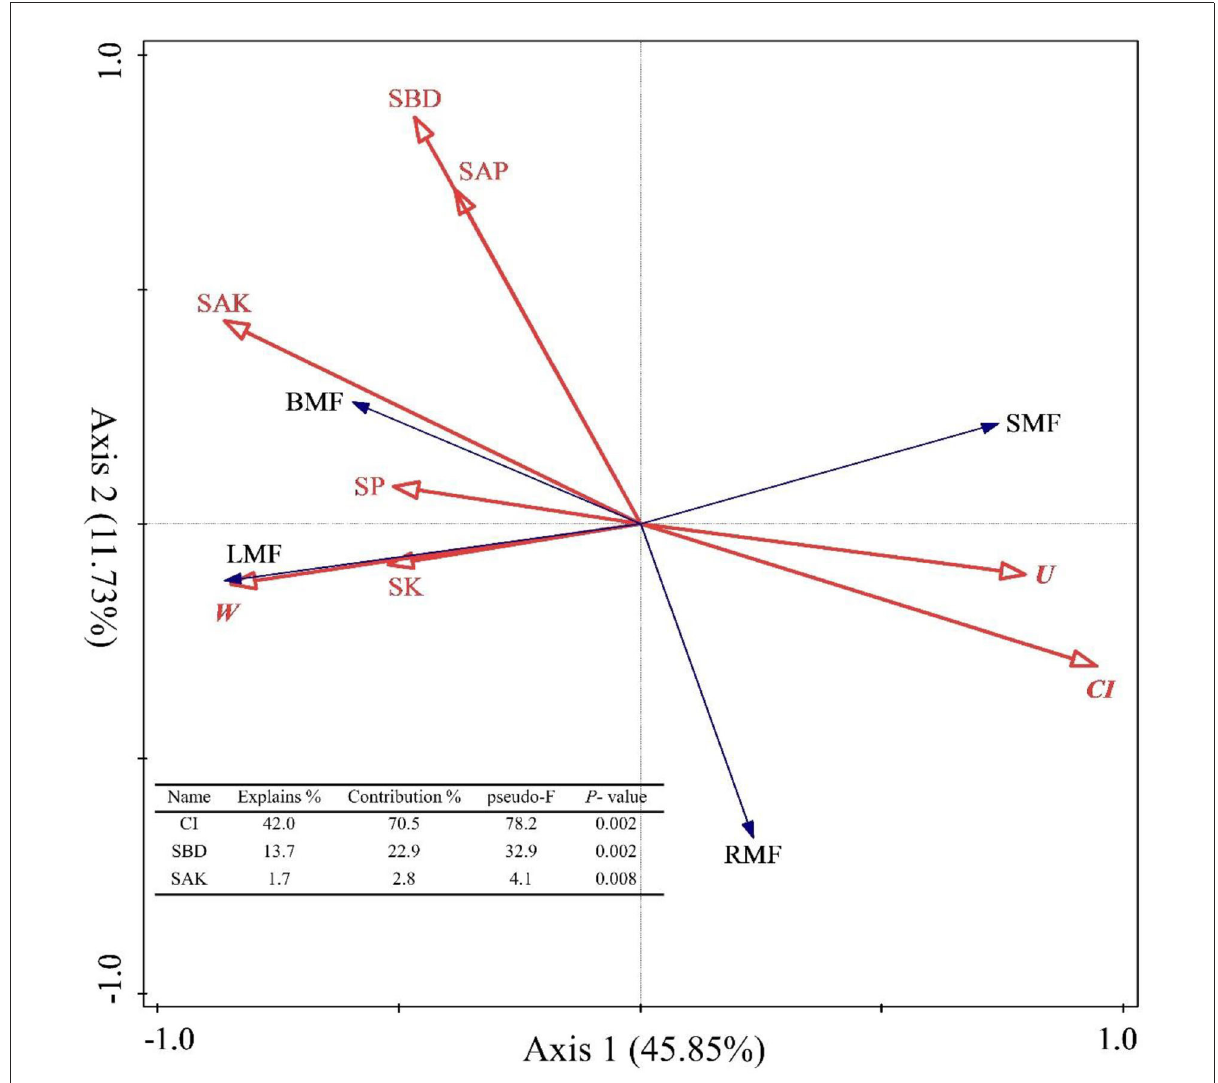
FIGURE6 Redundancy analysis (RDA) among the stand spatial structure characteristic indexes, environmental factors, and biomass allocation of organs. The angle between the two indicators represents a significant and positive relationship (acute angle, < 90 ◦ ) or negative relationship (obtuse angle, > 90 ◦ ). The length of the arrows is proportional to the magnitude of the standardized path coefficients (i.e., the strength of the relationship). The growth indexes are C/R ratio, crown-root ratio; H/D ratio, height-diameter ratio; and SQI, seedling quality index. The stand spatial structure parameters are M , mingling index; W , uniform angle index; CI , competition index; U , neighborhood comparison; and O , opening degree. The soil parameters are SOC, soil organic carbon; STN, soil total nitrogen; SAN, soil alkaline nitrogen; STP, soil total phosphorus; SAP, soil